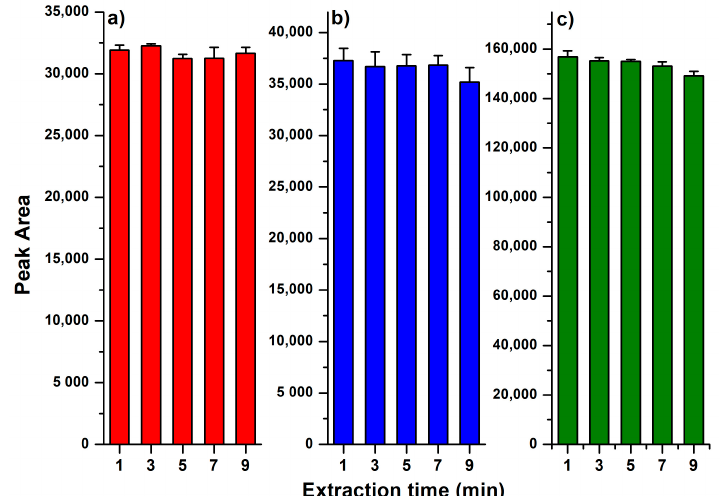
Figure 1. E ff ect of ultrasonic extraction time on extracted ascorbic acid from di ff erent bee pollen samples, ( a ) rape ( Brassica campestris ), ( b ) lotus ( Nelumbo nucifera ), and ( c ) camellia ( Camellia japonica ). The extract under di ff erent extraction times were analyzed by hydrophilic interaction liquid